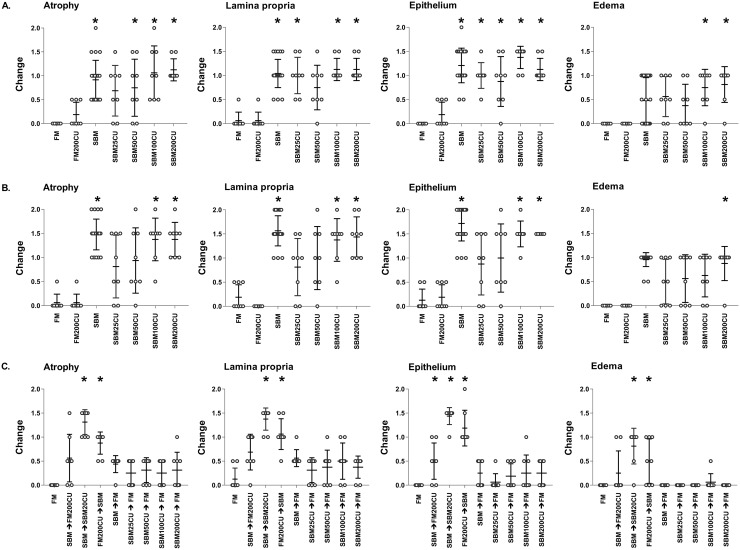
Histological evaluation.Histological evaluation of the distal intestine of Atlantic salmon based on atrophy, lamina propria, epithelium and edema at 7 (A), 30 (B) and 37 (C) days. Changes are scored from 0 to 2 where 0 indicates no changes and 2 indicates severe changes. Data are expressed as mean and standard deviation, n = 8 for all groups. Significant difference from the control fish fed FM based diet is denoted by an asterisk (*) (p<0.05; Dunn´s test). FM = fishmeal; FM200CU = fishmeal combined with 200 g/kg C. utilis (CU); SBM = soybean meal; SBM25CU = soybean meal with 25 g/kg CU; SBM50CU = soybean meal with 50 g/kg CU; SBM100CU = soybean meal with 100 g/kg CU; SBM200CU = soybean meal with 200 g/kg CU.